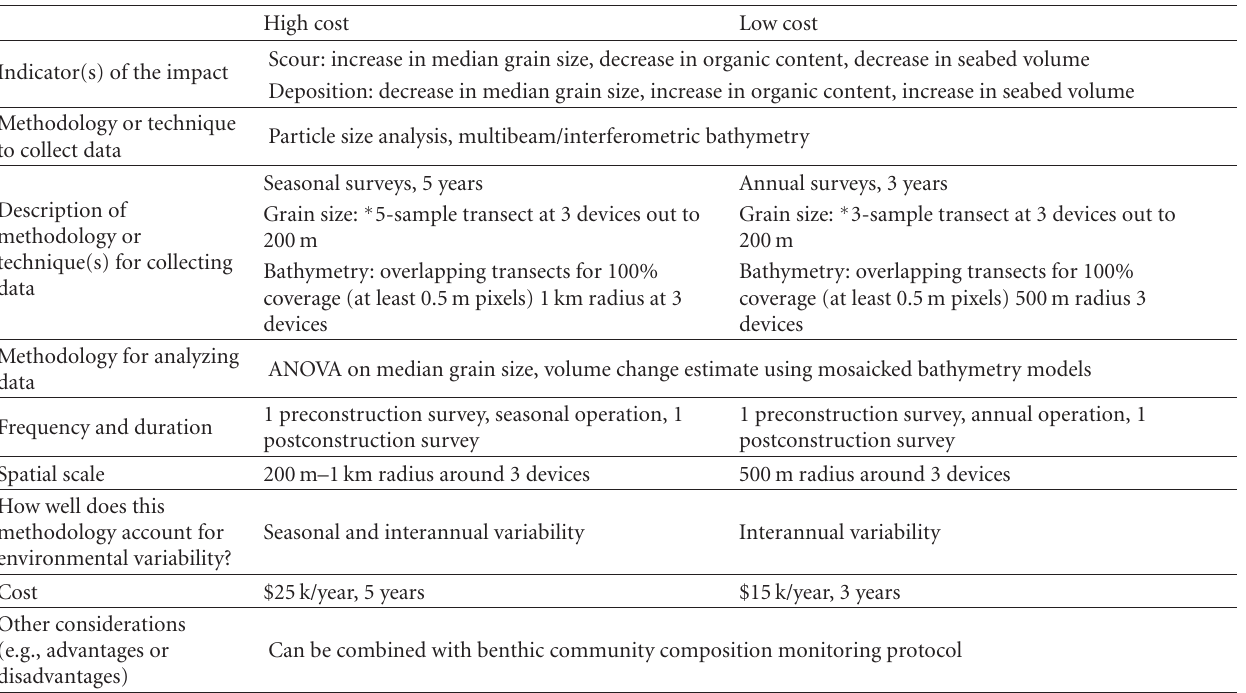
Table 15: An example monitoring protocol from the benthic habitat and resources category for seabed scour and/or deposition at a commercial-scale